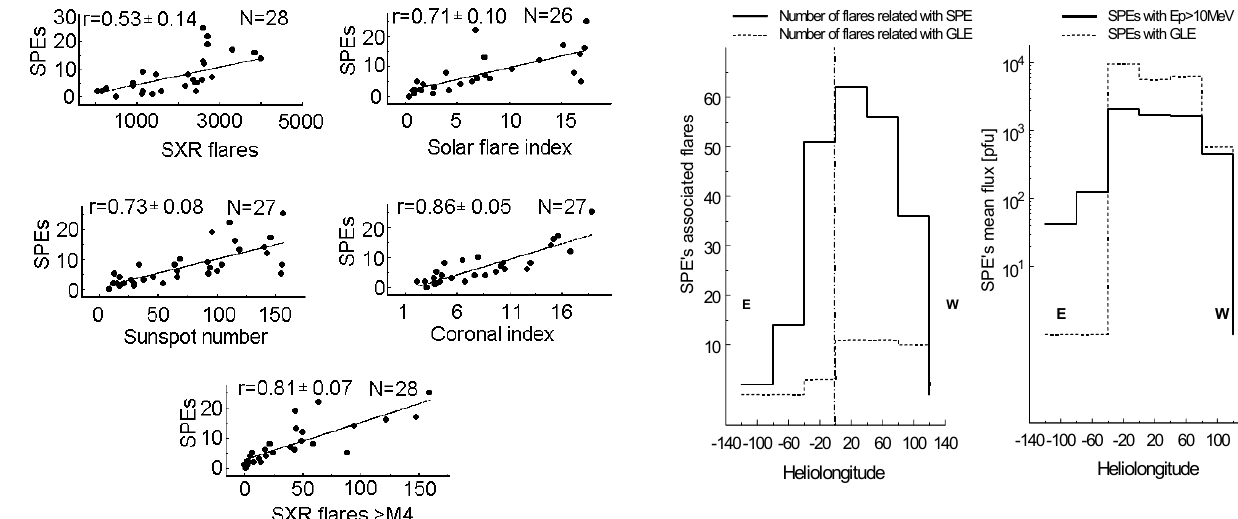
Fig. 6. Longitudinal distribution of the associated with SPEs flares Figure 6 and of the flares related to GLEs concerning the number of them (left panel) and the mean flux per 20 ◦ longitudinal interval (right